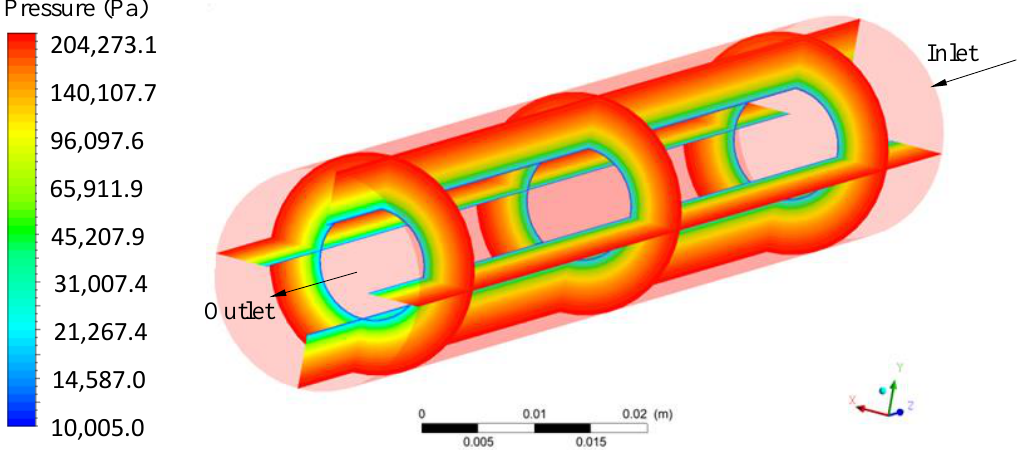
Figure 8. Pressure on the membrane at different , horizontal and vertical positions, of the filtration module.